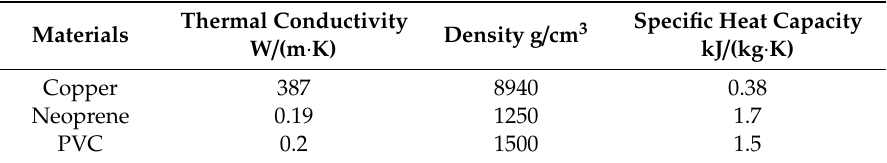
Table 1. Physical parameters of cable materials.